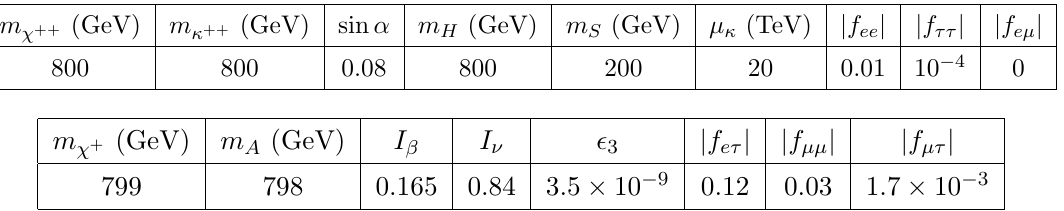
Table 3 . Benchmark values for the input parameters ((cid:12)rst row) and other relevant quantities derived from these inputs (second